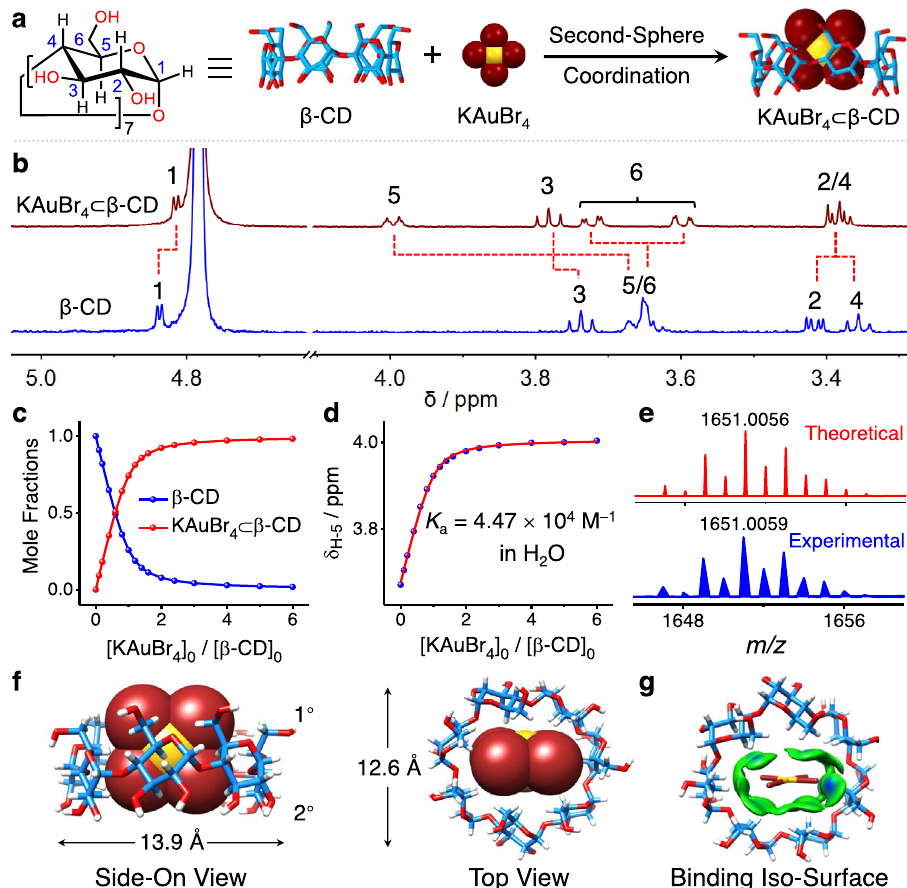
Fig. 1 | Host – guest interactions between β -CD and KAuBr 4 . a Schematic illus- tration of the recognition of [AuBr 4 ] − anions facilitated by second-sphere coordi- nation with β -CD. b 1 H NMR Spectra (600MHz, D 2 O containing 0.5M DBr, [ β - CD]=2.5×10 − 4 M, [KAuBr 4 ]=1.5×10 − 3 M, 298K) of β -CD and KAuBr 4 ⊂ β -CD. function of the KAuBr 4 -to- β -CD ratio during the 1 H NMR titration. d 1 H NMR TitrationisothermcreatedbymonitoringchangesinthechemicalshiftofH-5upon